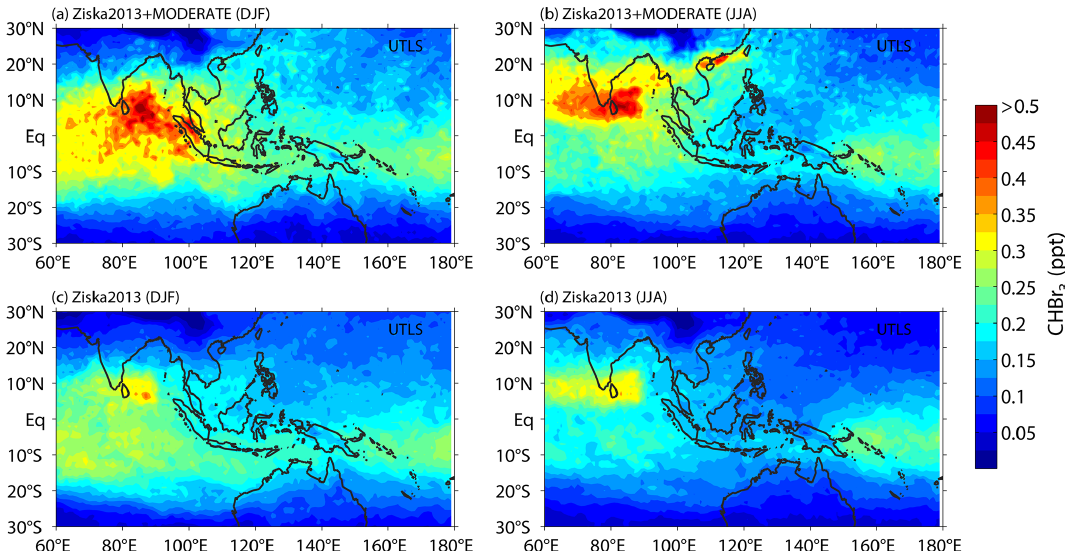
Figure 10. Seasonal mean atmospheric CHBr 3 mixing ratios [ppt] for (a, b) the Ziska2013 + MODERATE and (c, d) the Ziska2013 simu- lation at the cold-point tropopause height for (a, c) DJF and (b, d)